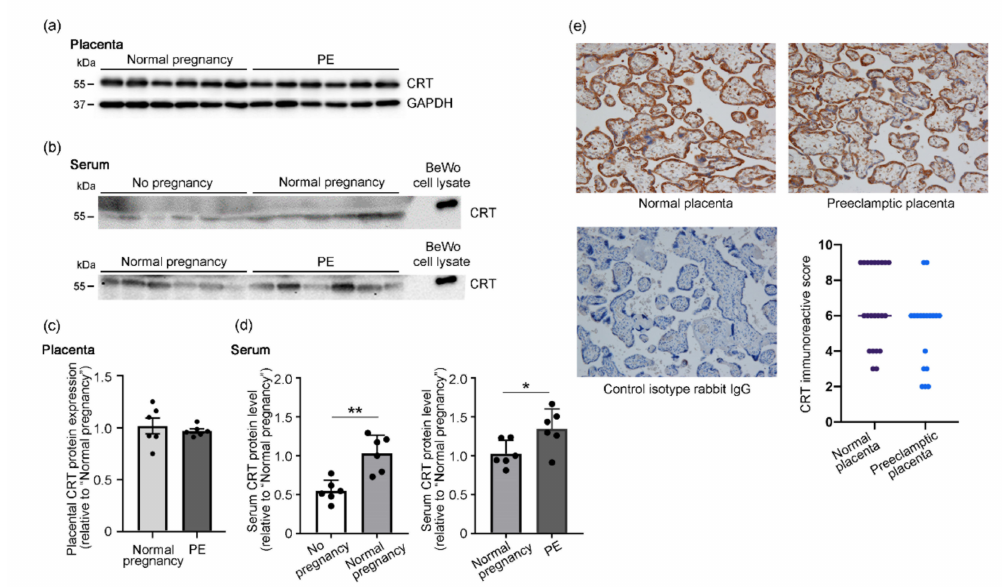
Figure 1. Upregulation of serum CRT levels in patients with preeclampsia. CRT protein levels in placental ( a ) and serum ( b ) samples obtained from nonpregnant women (n = 6), women with normal pregnancies (n = 6), and patients with preeclampsia (PE; n = 6) were analyzed by using Western blotting. Cell lysates that were prepared from BeWo cells under conventional culture conditions served as the reference for the CRT-immunoreactive band. GAPDH was used as the loading control in ( a ). For analysis of serum samples in ( b ), 100 µ g of total proteins were loaded in each well. ( c , d ) Quantitative analysis of the immunoblots in ( a ) and ( b ). ( e ) Representative images of immunohistochemical analysis of CRT in normal placentas (n = 22) and preeclamptic placentas (n = 18). The graph provides CRT IRSs. Data are presented as means ± standard deviation (SD). * p < 0.05; ** p <